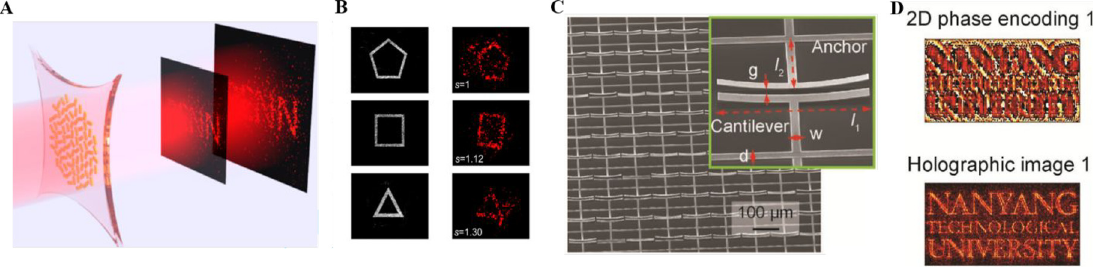
Figure 7: (A) Schematic of the multiplexed metasurface holograms on a stretchable substrate. (B) Reconstructed images that are captured at theobservationplanewhenthesubstrateisstretchedtodifferentratios[40].(C)SEMimageofthepre-stressedcantileverbasedmetamaterial and the (D) computational results of holographic image